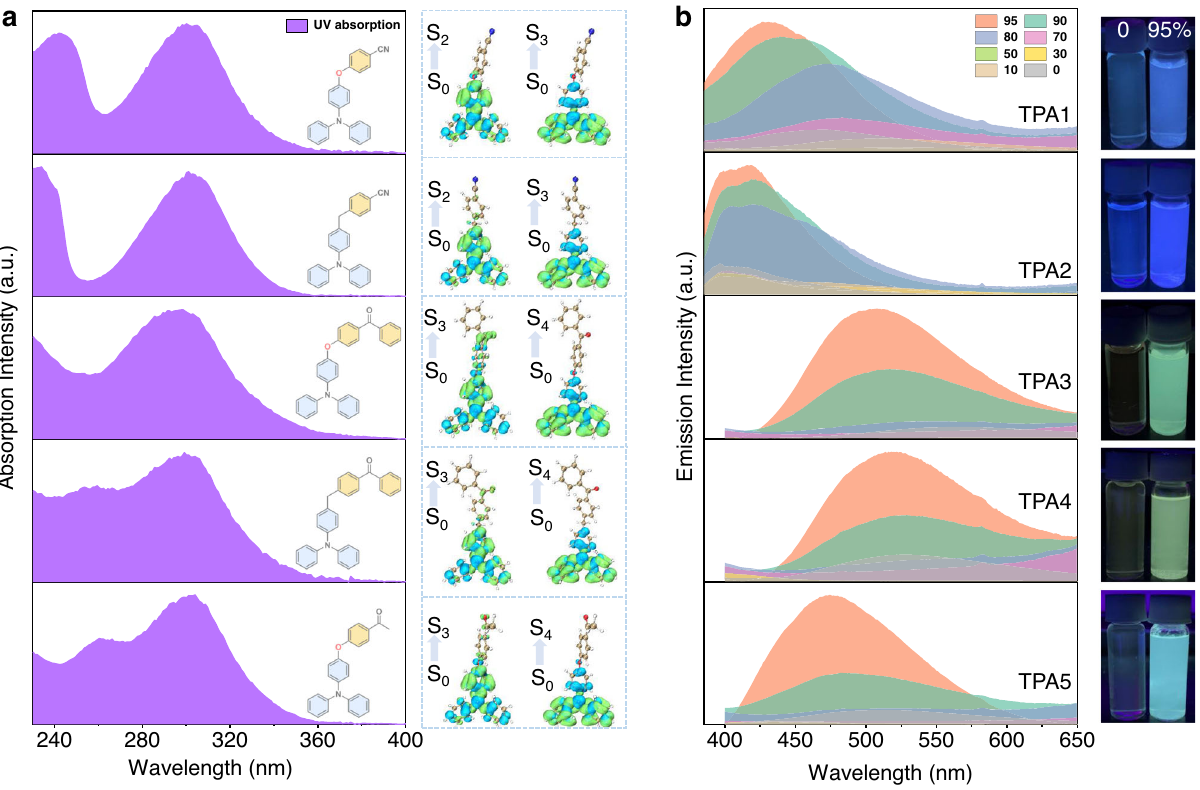
Fig. 2 AIE investigations. a Normalized absorption spectra (left) of TPA1-5 in optically dilute THF solutions and corresponding hole (blue) – electron (green) distributions (right) calculated based on the TD-DFT method. b Steady-state emission spectra of TPA1-5 in a bicomponent solution mixture showing the AIE process with different THF/water ratios (0 – 95%, v/v) and related AIE photos under a hand-held UV lamp (water fraction: 0 and 95%, TPA concentration: 2.0 × 10 − 3 mol/L).